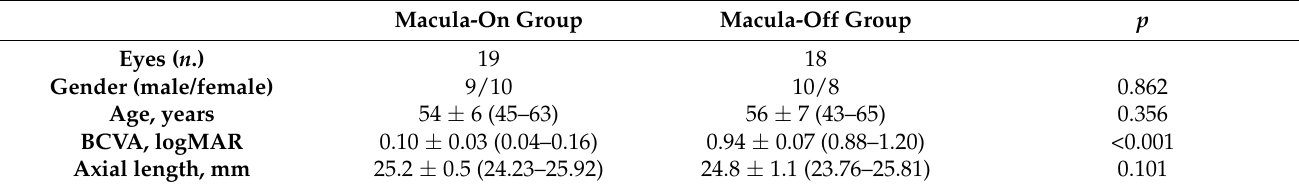
Table 1. Baseline demographic and ocular characteristics of the included patients. Macula-On Group Macula-Off Group p Eyes ( n .)